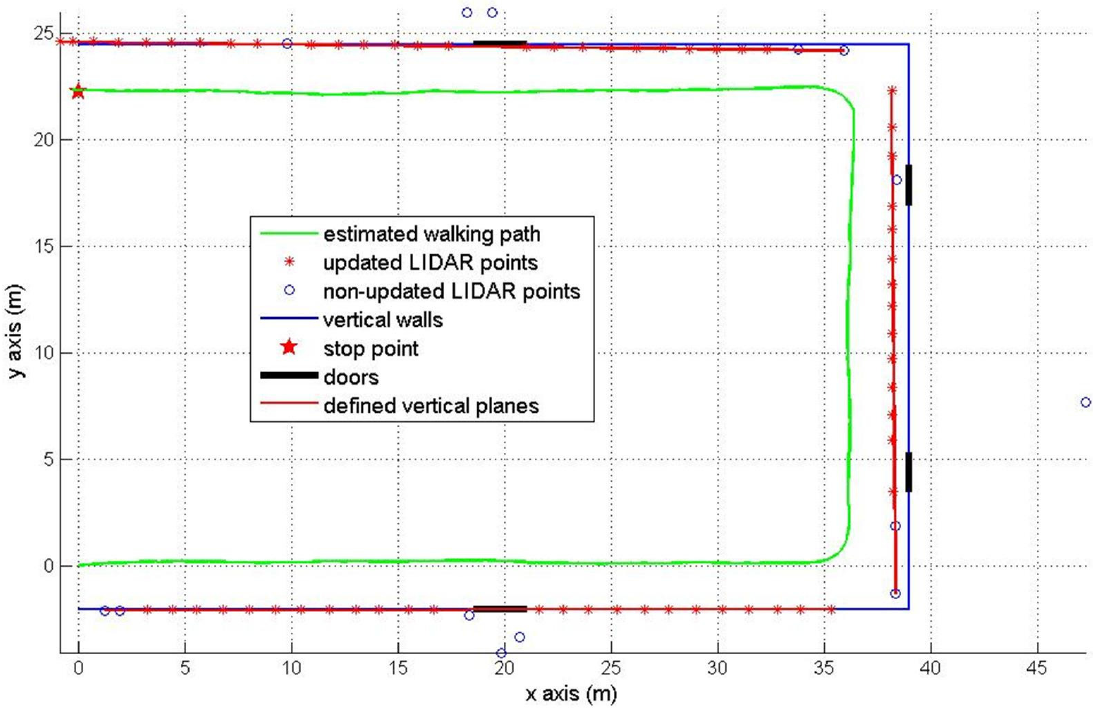
Figure 11. Pedestrian path in the U shaped corridor using the proposed method.